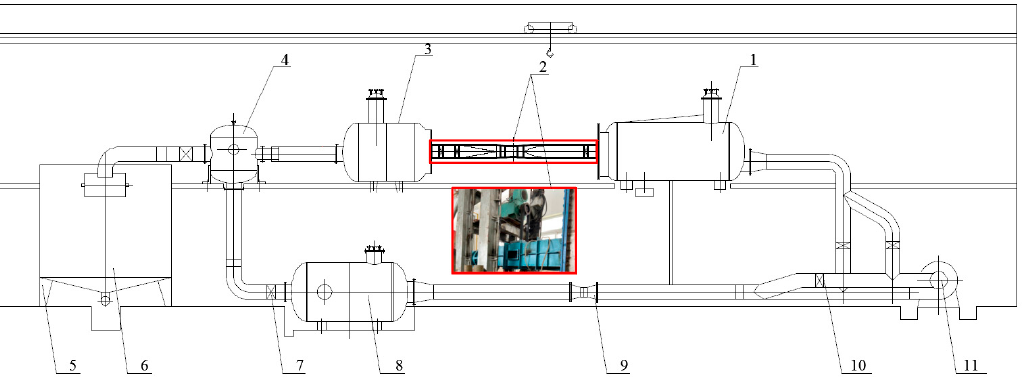
Figure 4. High-precision hydraulic machinery test bench. (1) Inlet tank. (2) Tested pumping device and drive motor. (3) Pressure outlet tank. (4) Bifurcated water tank. (5–6) Flow in situ calibration device. (7) Condition regulating valve. (8) Pressure stabilizing rectifier cylinder. (9) Electromagnetic flowmeter. (10) Forward and reverse operation control gate valve. (11) Auxiliary pumping